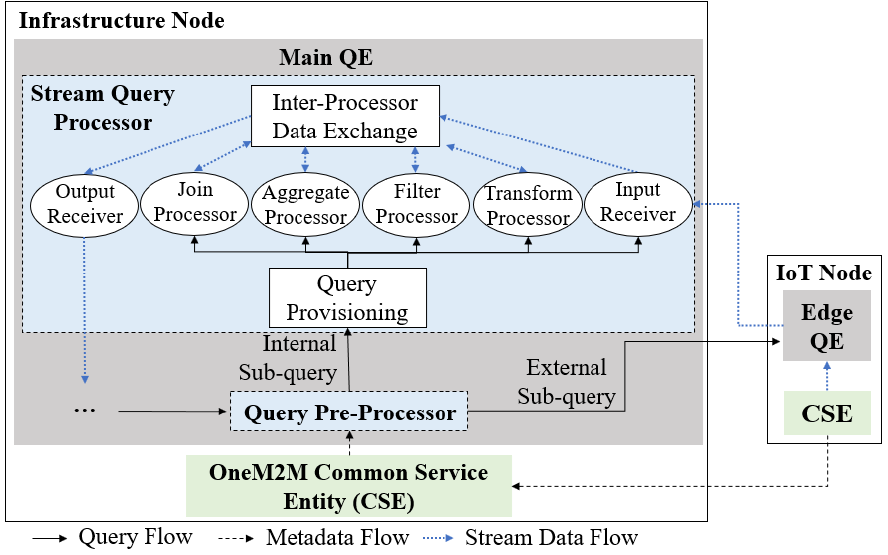
Figure 11. Stream Query Processor